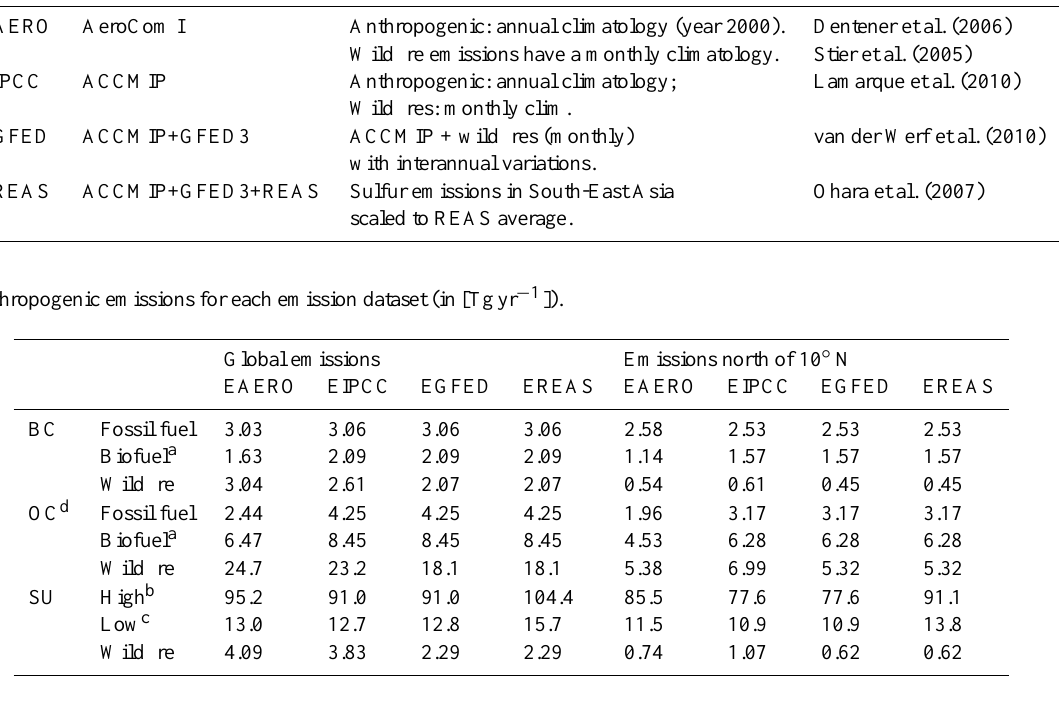
Table 1. Emission datasets used for ECHAM5-HAM runs. Label Emission inventories Description Reference Anthropogenic: annual climatology (year 2000). Wildfire emissions have a monthly climatology.